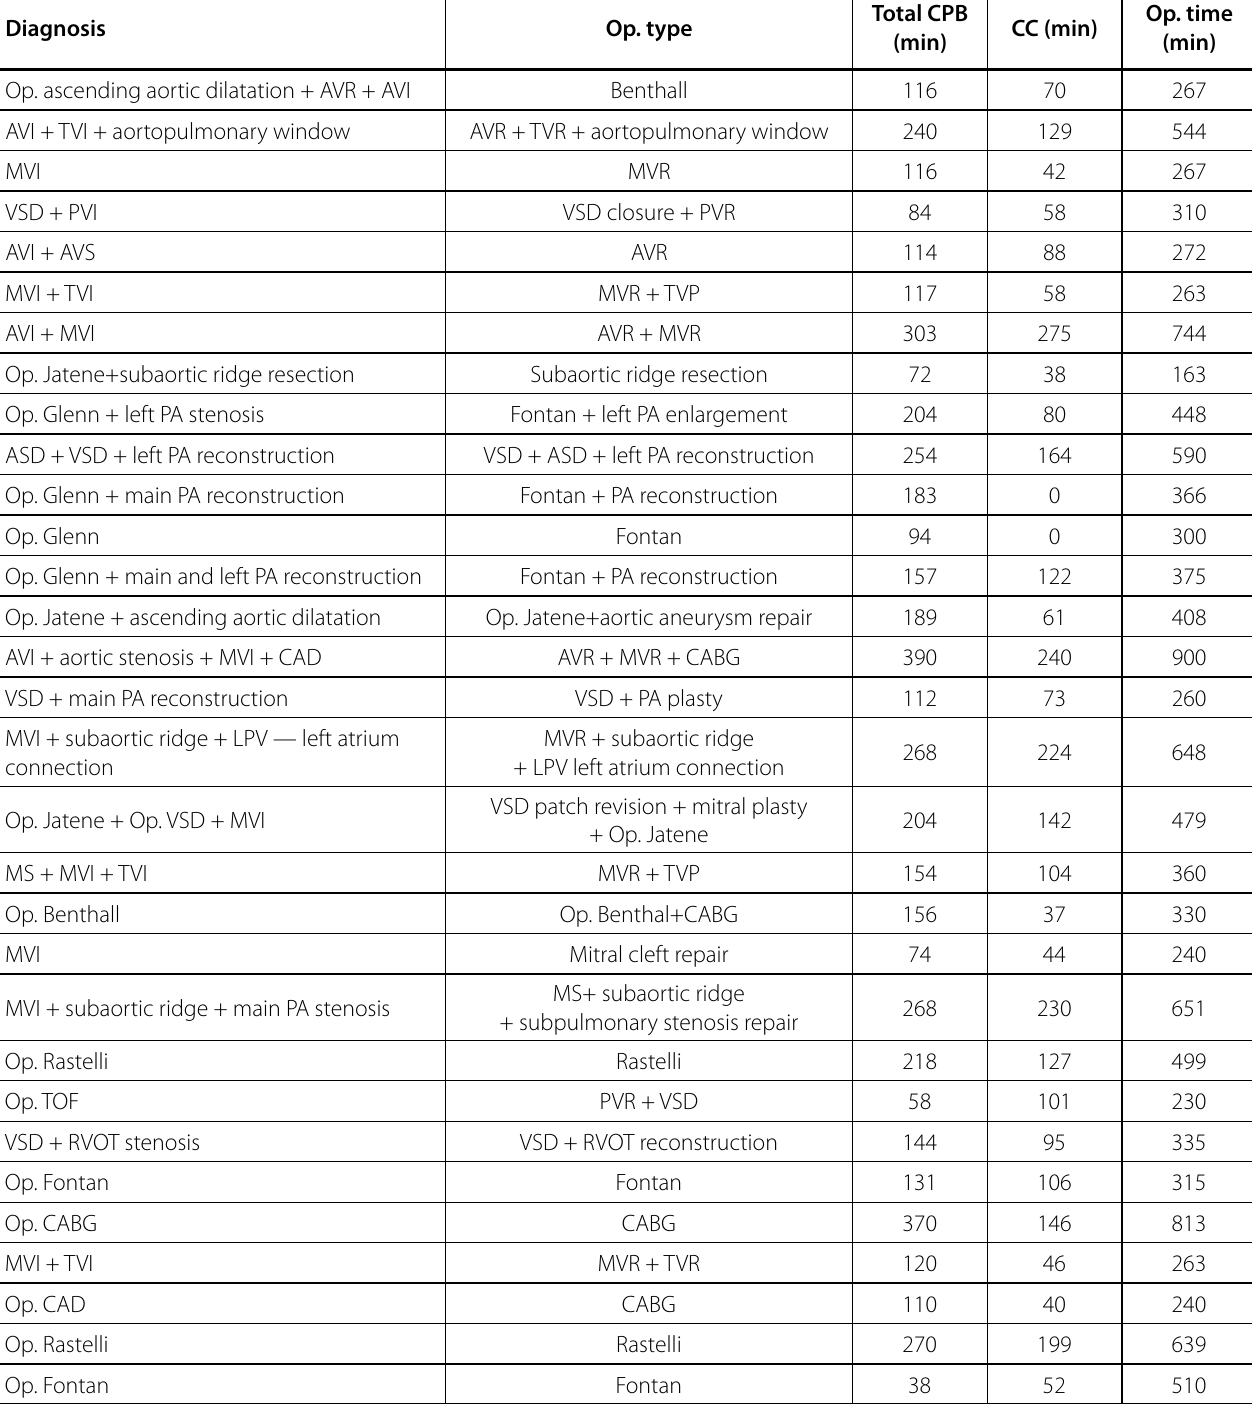
Table 2 . Features of the conventional cannulation group (diagnosis, operation type, and